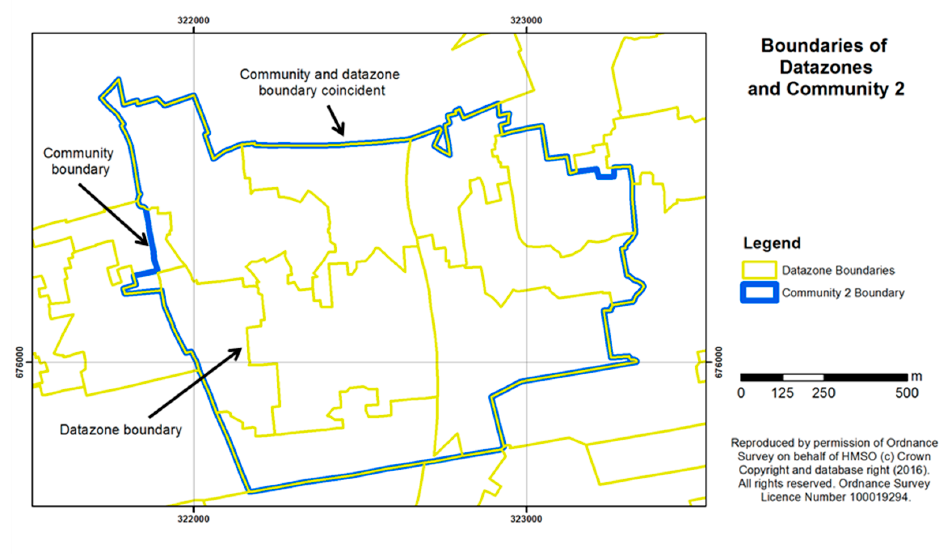
Figure 6. Community 2 outline showing boundaries of the datazones used for calculating the percentage area of green space per survey participant.